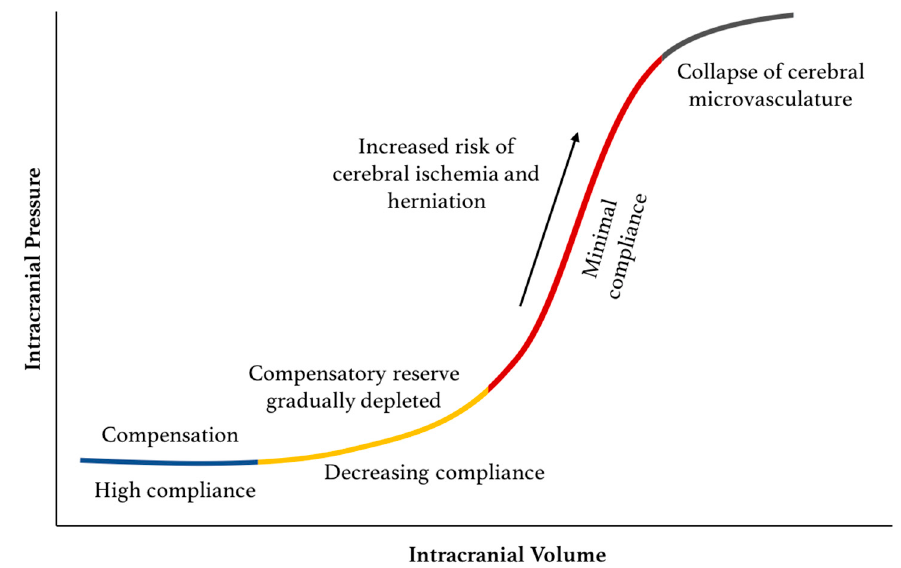
Figure 2. Pressure–volume curve for ICP. The pressure–volume curve has four ‘zones’: (1) baseline intracranial volume with good compensatory reserve and high compliance (blue); (2) gradual depletion of compensatory reserve as intracranial volume increases (yellow); (3) poor compensatory reserve and increased risk of cerebral ischemia and herniation (red); and (4) critically high ICP causing collapse of cerebral microvasculature and disturbed cerebrovascular reactivity (grey).